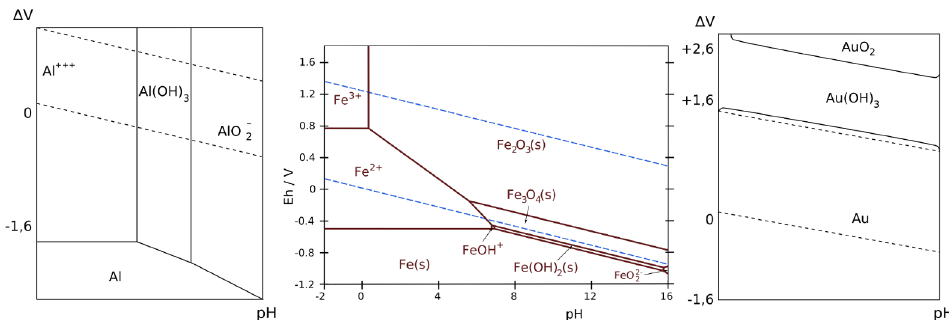
Fig. 6. – Pourbaix diagrams for aluminium, iron and gold. Dashed lines denote the stabil- ity window of water. (Source: Wikimedia commons.wikimedia.org/wiki/File:Fe-pourbaix- diagram.svg , https://commons.wikimedia.org/wiki/File:D-pourbaix-Al.svg , commons. wikimedia.org/wiki/File:Pourbaix-Au.svg under Creative Commons Attribution-Share Alike 3.0 Unported